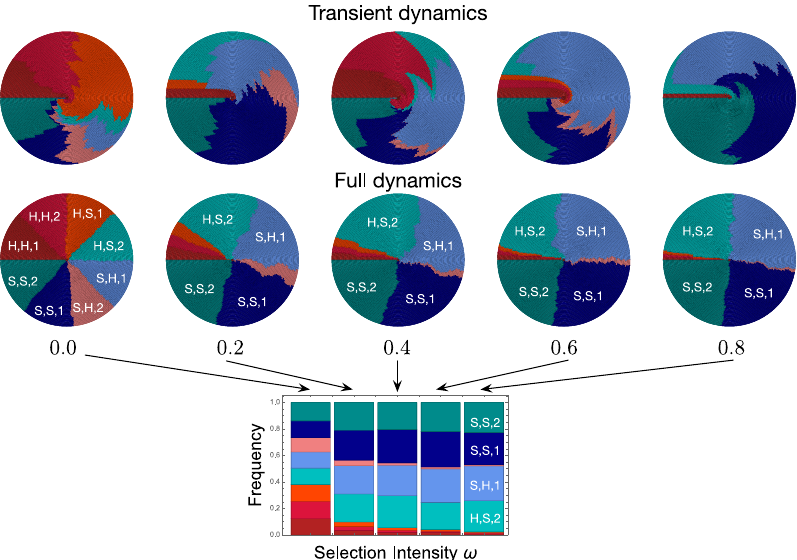
Fig. 5 Abundance plots for the eight strategies in a fi nite population. All simulations begin with a population consisting of (H,H,1). The circular fi gures are pie-charts evolving over time (initial condition inside and time progresses outwards). The rings of the charts show the population composition (denoted by the different colours) as it changes through time. Transient: For different selection intensities the initial conditions are all the same - starting in a (H,H,1) population (the centres of the circles). With a mutation rate of μ = 10 − 3 new strategies appear and spread in the population. Every 20th time-step up to 1000 time-steps are plotted, from inside to outside. Full: Over time (5 × 10 6 time-steps) the population reaches stationarity. Every 1000 th time-step is plotted. The fi nal distribution of strategies (outermost layer of the circles) is collated in the bar-chart. Bottom: The fi nal distribution of the strategies at time- step 5 × 10 6 is plotted as a stacked bar chart for the different section intensities. When selection intensity ω = 0 the dynamics is neutral and all the strategies evolve to similar abundances. When selection intensity is increased even slightly ω = 0.2 the population is made up predominantly of stag hunters. Note that it is not necessary that all stag hunter share the same inter-subjective reality. Parameters are N = 32, G = 5, M = 4, P S = 4 and P H = 1.